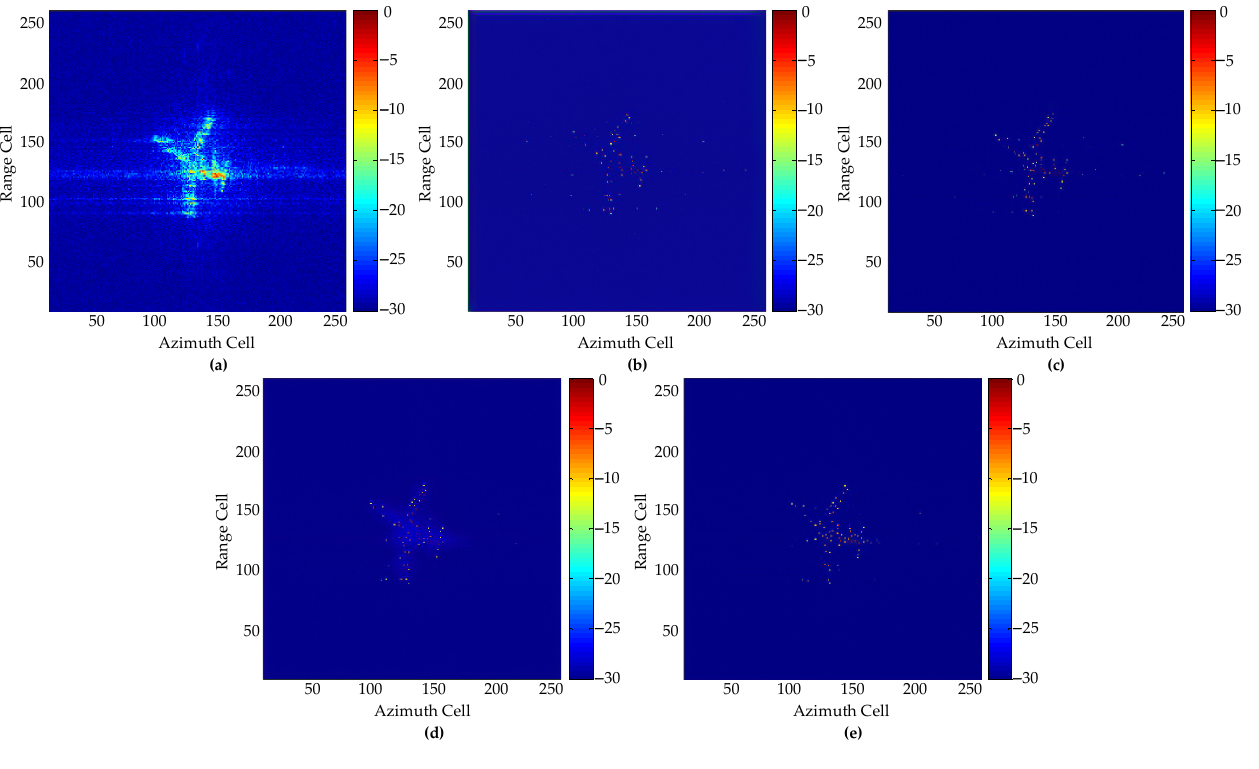
Figure 9. Imaging results of Yak42 at SNR = 2 dB: ( a ) IFFT; ( b ) GAN1; ( c ) GAN2; ( d ) GAN3; ( e ) Proposed GAN. Table 5. Numerical performance evaluation for Yak42 at SNR = 2